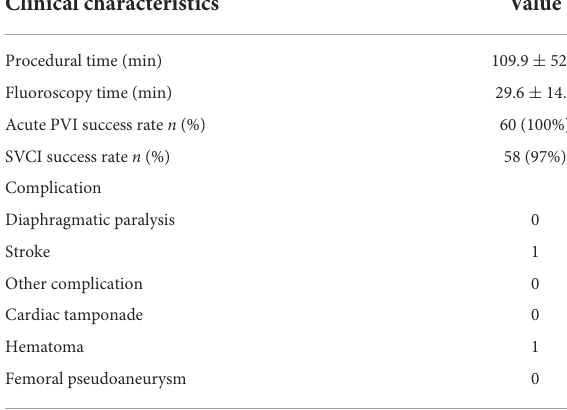
TABLE 1 Patient baseline characteristics. TABLE 2 Procedural characteristics and